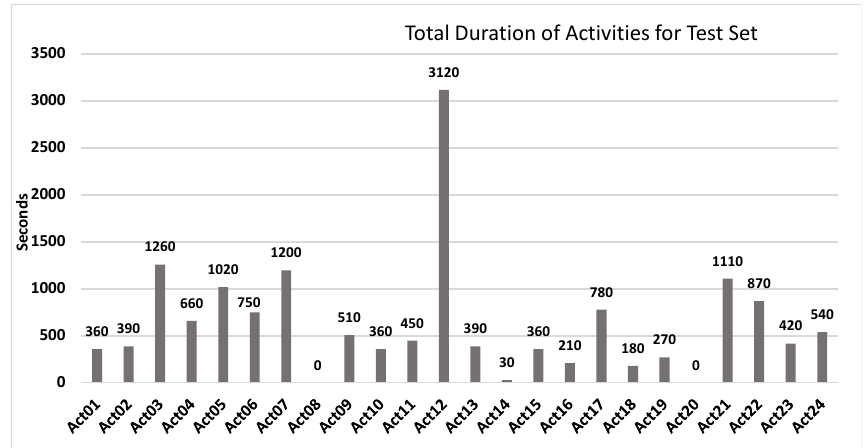
Figure 4. Life-time for the individual activities for UJAmI Smart Lab Test dataset.